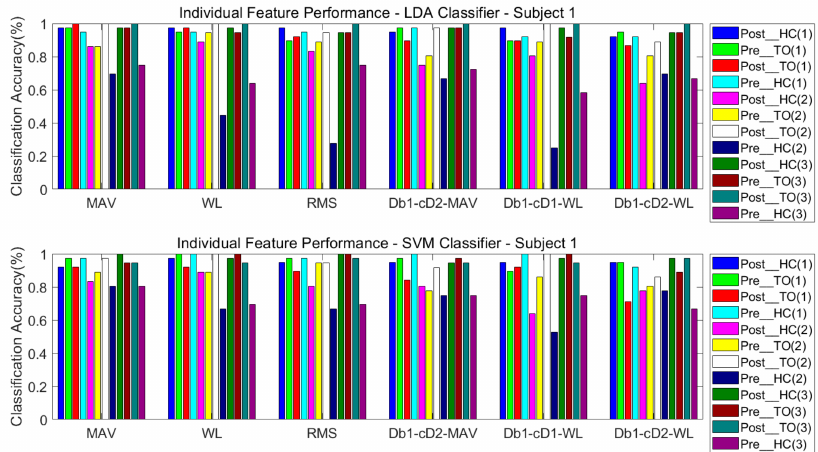
Figure 8. Classification performance of individual sEMG features; Subject